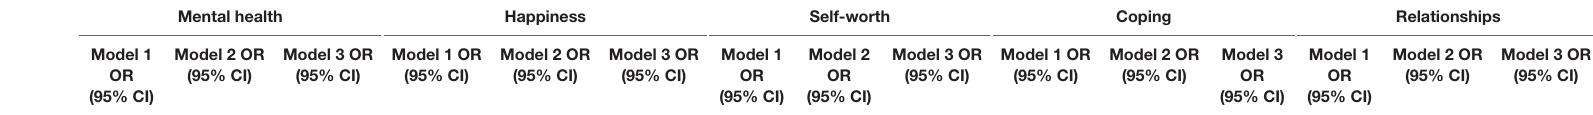
TABLE 5 | Multiple logistic regression analysis of the association of tinnitus severity and psychological dimension of